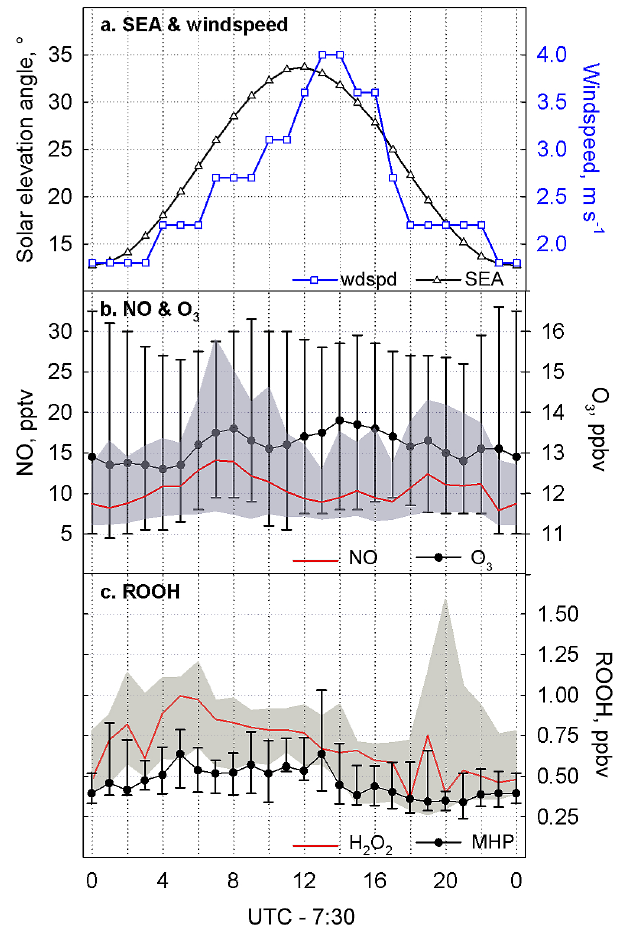
Fig. 2. Diel variation of (a) average solar elevation angle (SEA) and wind speed, (b) median NO (left axis) and O 3 (right axis), and (c) median H 2 O 2 and MHP. Symbols and lines are 1h binned values centered on each hour; shaded area and error bars indicate the range between the first and third quartiles; local time is UTC −